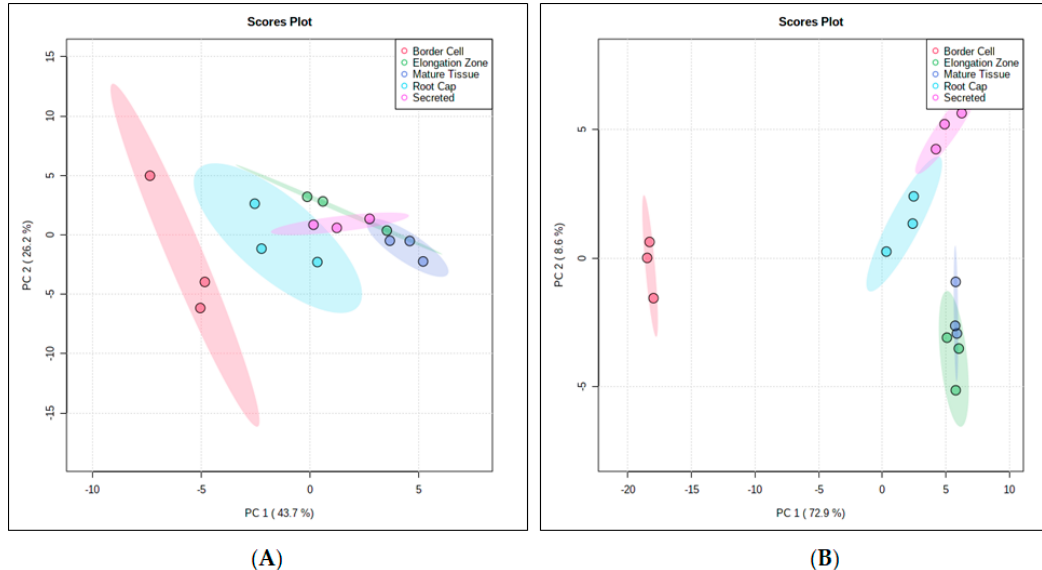
Figure 5. PCA Analyses of GC-MS polar ( A ) and GC-MS nonpolar ( B ) Medicago truncatula Root Fractions. PCA analysis of the GC-MS polar data shows a separation between fractions, with border cells separating away from other fractions. Nonpolar GC-MS analysis also showed separation between fractions, with border cells again separating away from other fractions. For both analyses, root tissue fractions showed less separation. These data illustrate the differential accumulation or spatial localization of metabolites within unique root